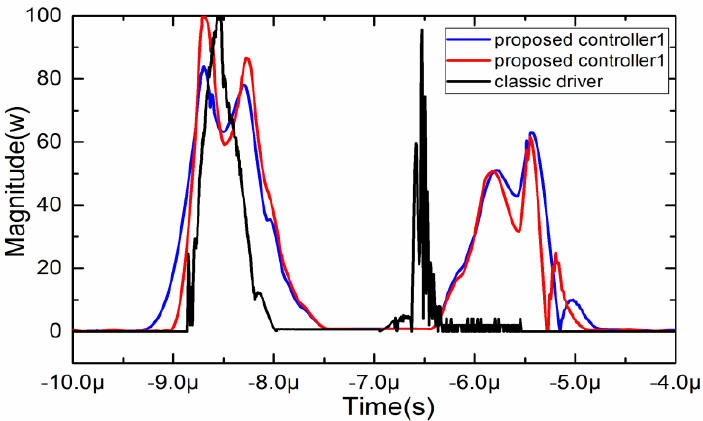
Figure 19. Power comparison between the proposed controller 1, the proposed controller 2, and classical gate driver.